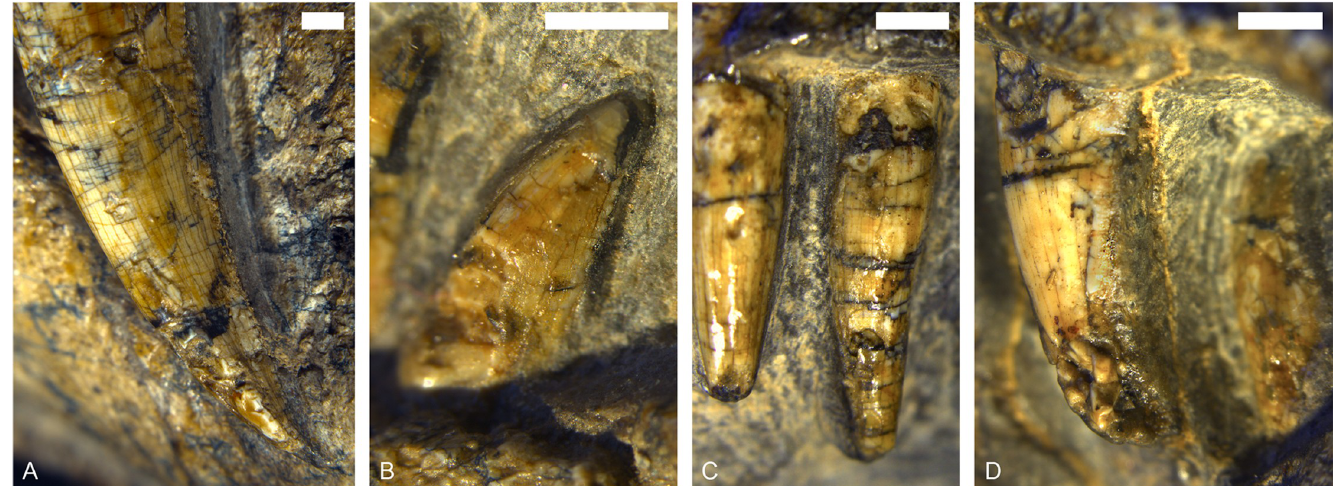
Fig 7. Dentition of MB.R.999. (A) left upper canine, (B) third lower postcanine, (C) first and second upper incisors, (D) first upper incisor.